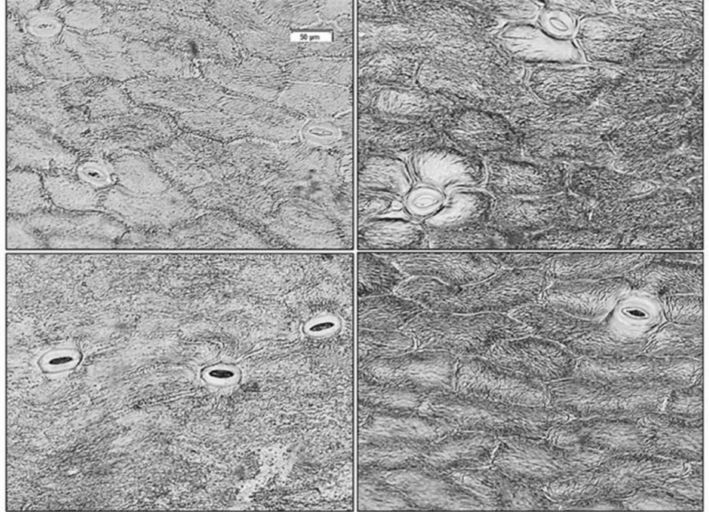
Figure 1. The imprints of sepal adaxial ( upper ) and abaxial ( lower ) surfaces of Helleborus odorus ( left ) and H. niger ( right